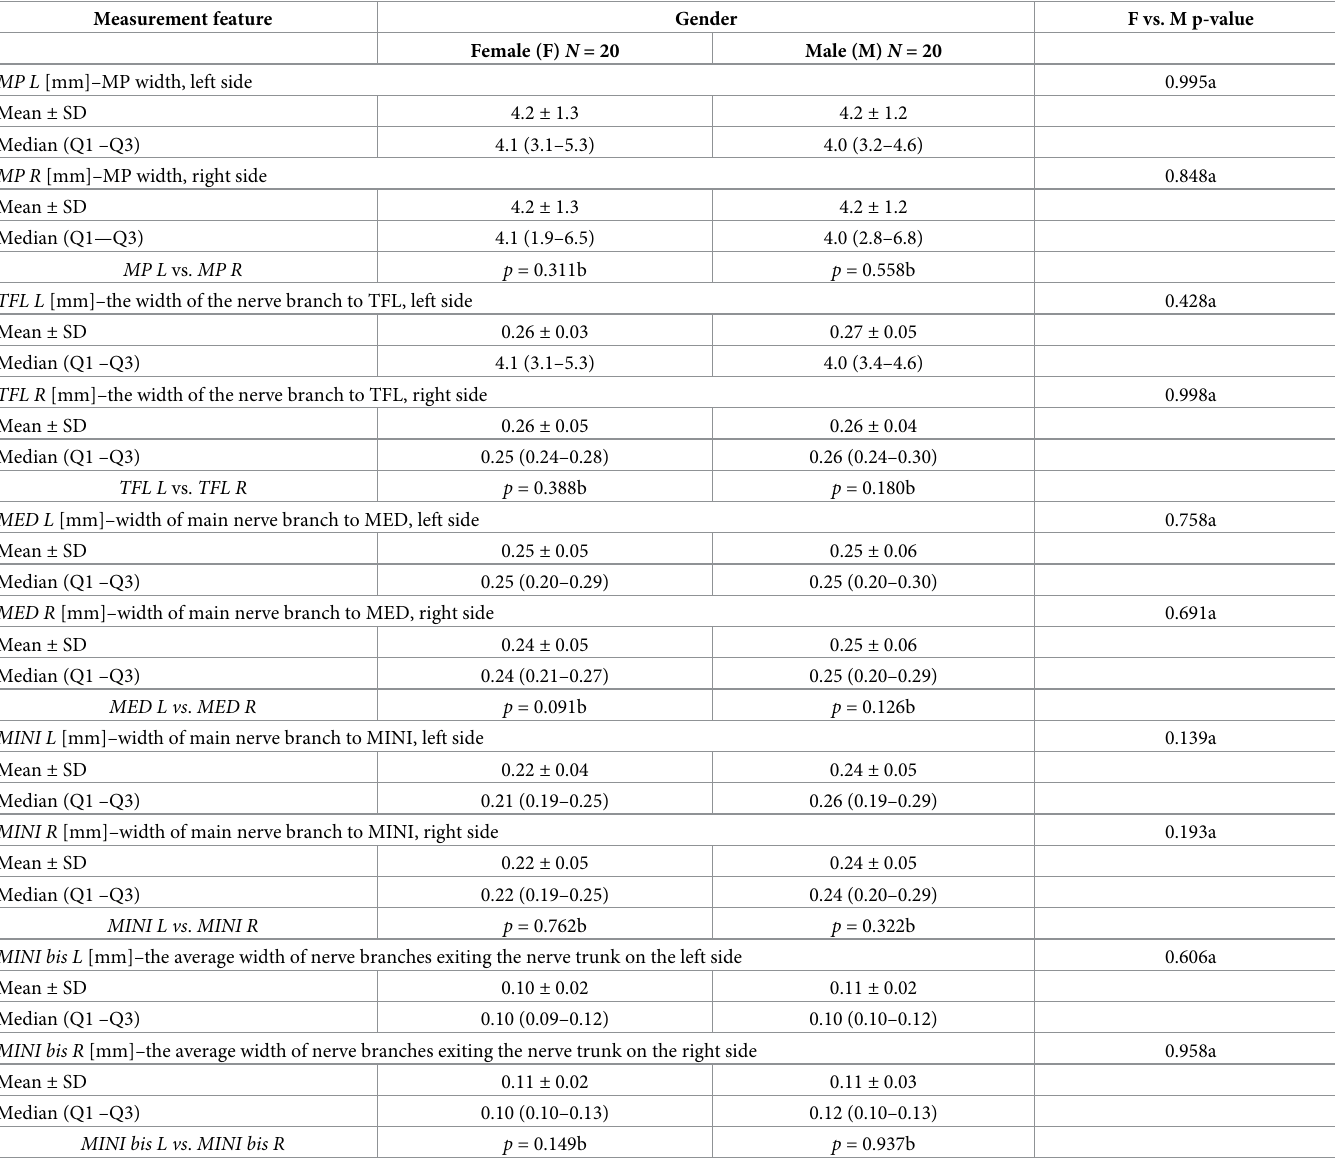
Table 3. Width of the superior gluteal nerve branches to the particular muscles in respect to sex and laterality. Measurement